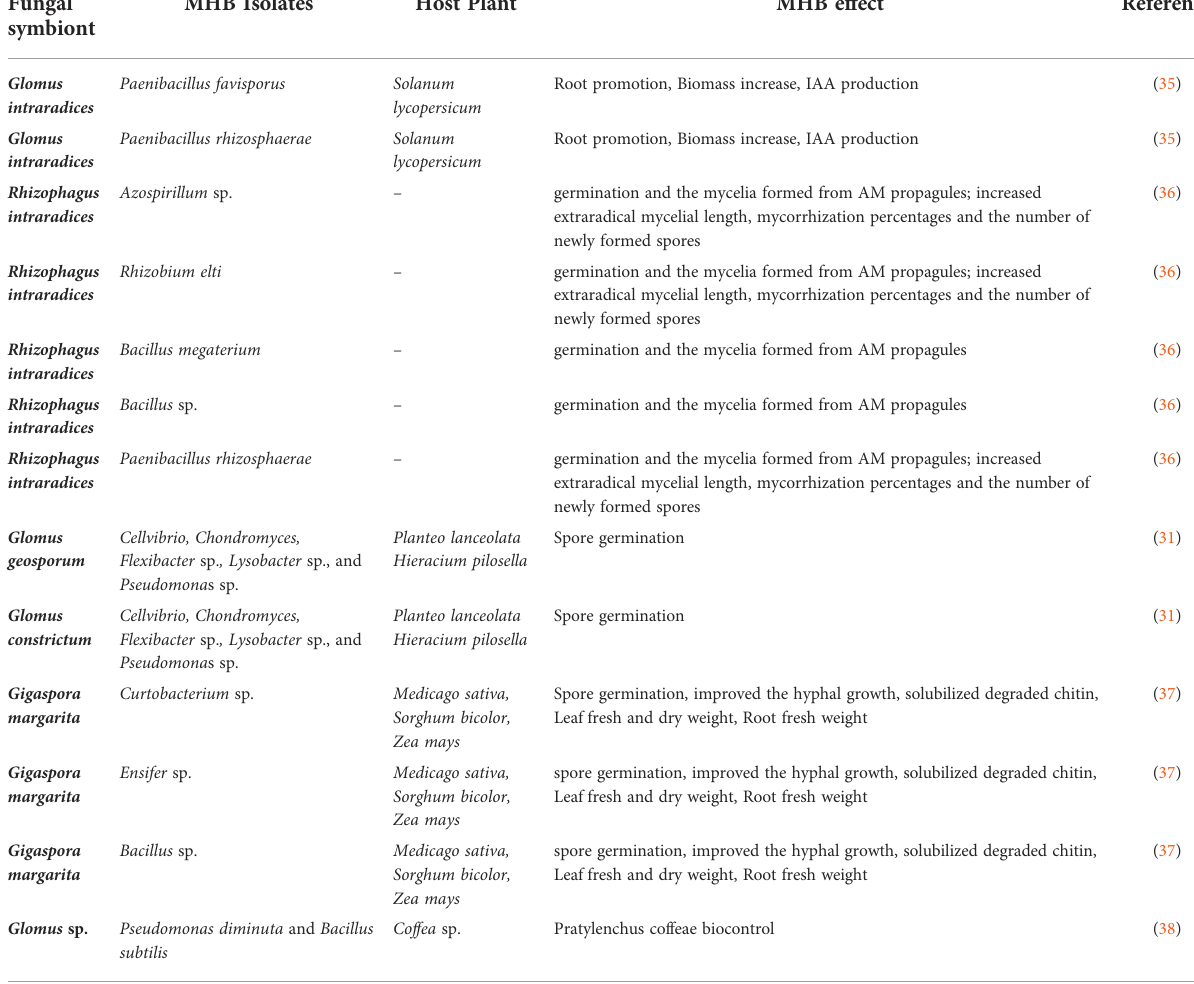
TABLE 1 Examples of MHB effects on AMF establishment and on the impacts on plant